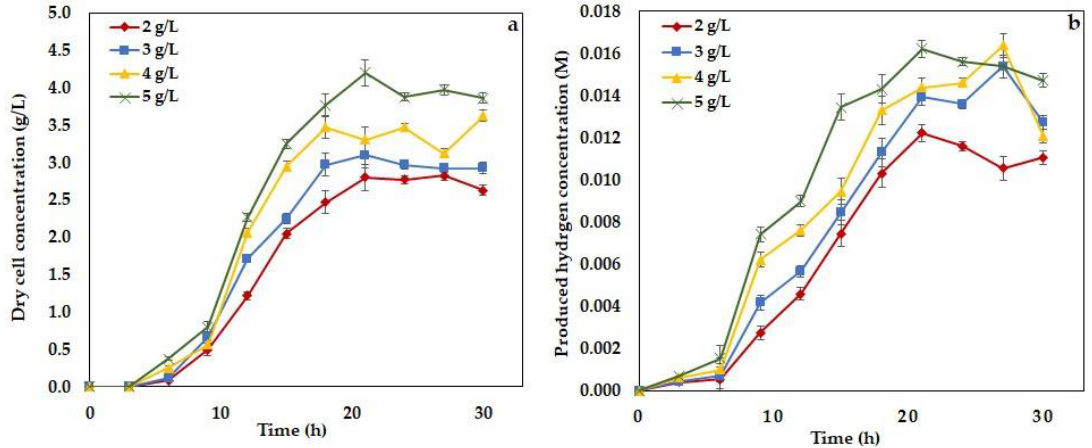
Figure 5. Experimental time histories of dry cell concentration ( a ) and hydrogen concentration ( b ) with initial 0% H 2 in reactor headspace at different substrate concentration.